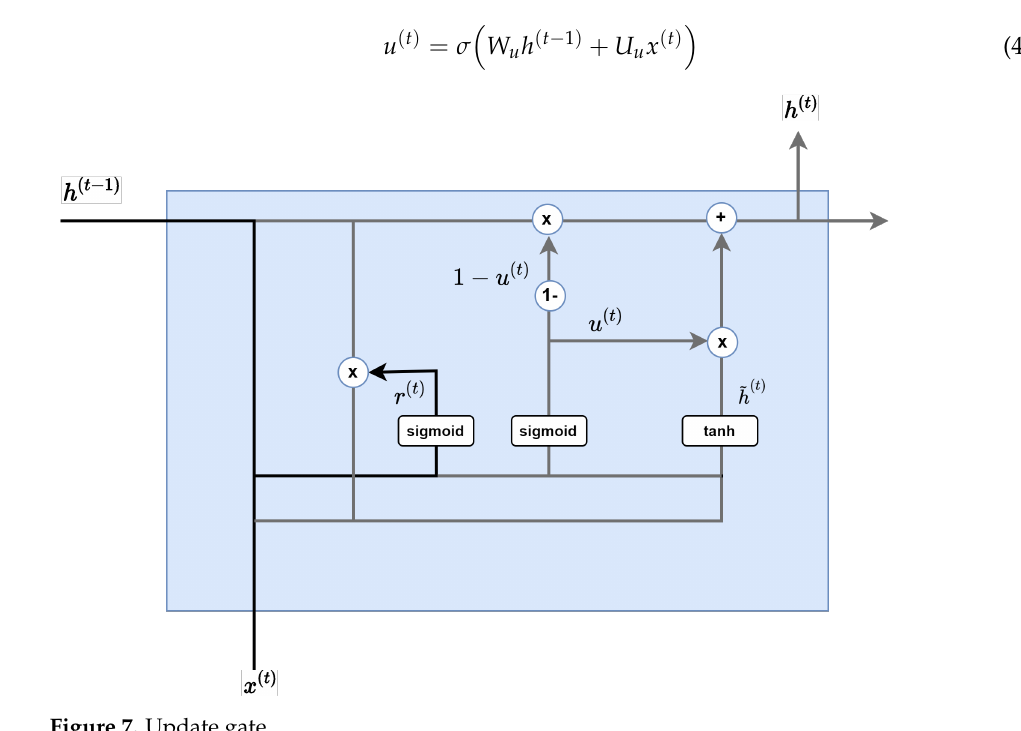
Figure 7. Update gate.